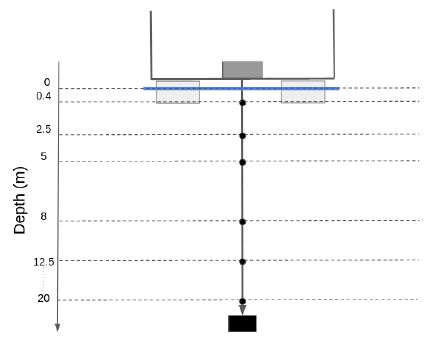
Figure 5 . Scheme of the position of the DO sensors. From the 5 th of November 2020 to the 10 th of March 2021, 161346 raw data (1-minute frequency) were collected for each parameter sensed and for each of the six sensors installed on the system. In Figure 6. Graphs produces by the web user interface showing water temperature (°C) and DO data (as % saturation) at 0.4 meters., a screenshot of the data graphs built using the user interface is shown. The data shown are those collected by the sensor located at 0.4 meter depth. The station worked well for the whole period, except during 3-15 December, when the monitoring system stopped working due to a power issued which was then solved.